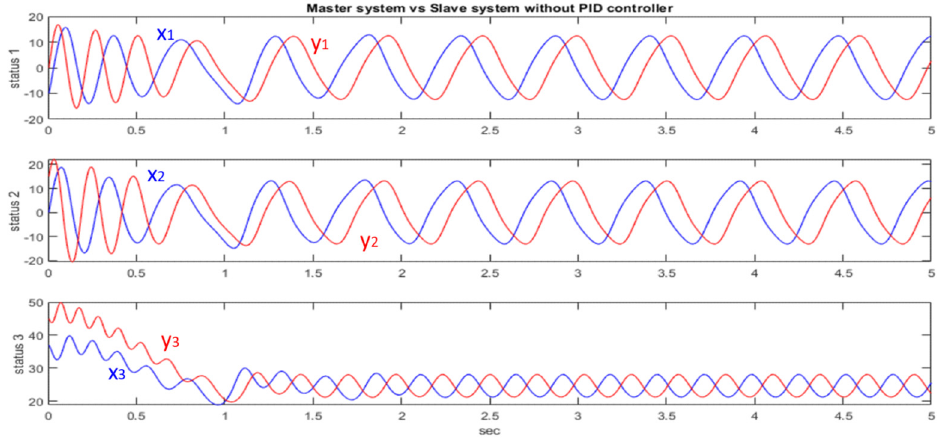
Figure 4. Response to different initial values.